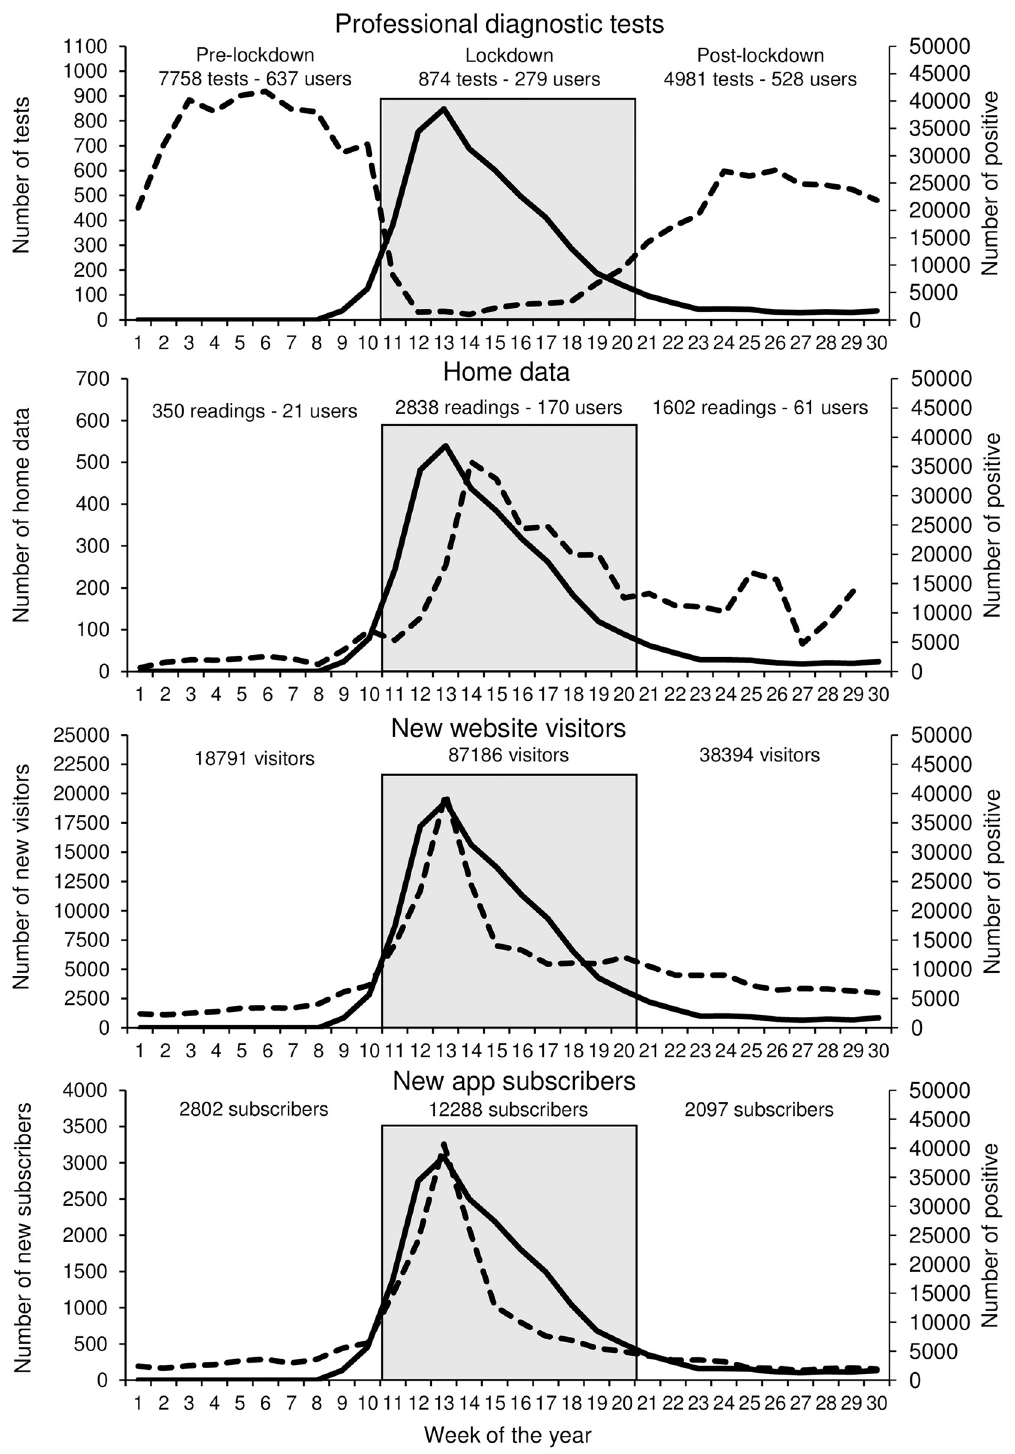
Fig 1. Weekly number of professional tests, home data, new visitors to the telemedicine website, and new app subscribers (dashed lines). The thick continuous line represents the number of positive to SARS-CoV-2 tests. Pre-lockdown, lockdown, and post-lockdown periods are also